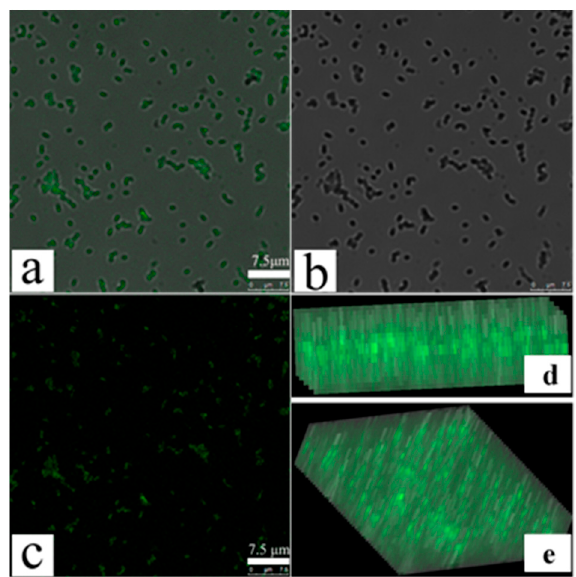
Figure 4. Laser confocal scanning microscopy of fluorescein isothiocyanate (FITC) cellular uptake after permeabilization of bacterial membranes. Multidrug-resistant P. aeruginosa cells (9 × 10 8 CFU/mL) were incubated with 30 μ g/mL POGH for 60 min. ( a ) The original image of POGH-treated cells observed by the ordinary fluorescence mode; ( b ) the image observed by the mode of Differential Interference Contrast (DIC); ( c ) the merged image of the corresponding original image and the DIC image; ( d , e ) the corresponding images in the y – z plane.